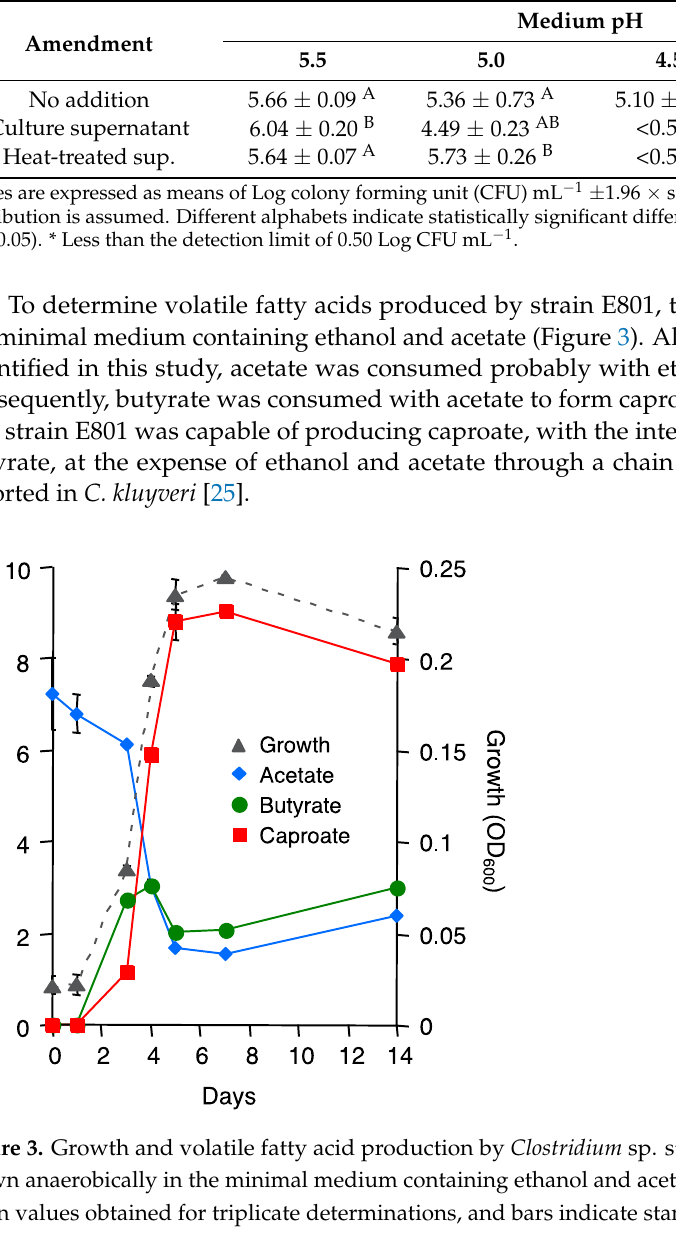
Table 2. Effect of volatile fatty acids on Fol growth. Amendment